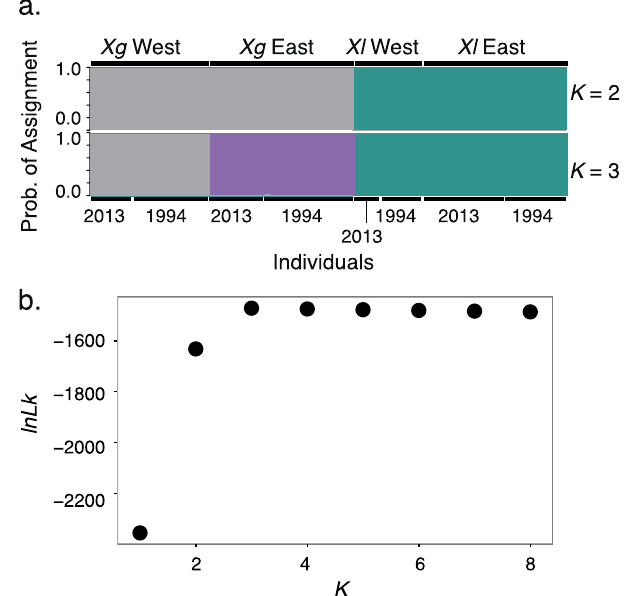
Figure 4. ( a ) Structure analyses for 10 loci, which had sequence data for all populations. ( b ) Likelihood for each value of K .